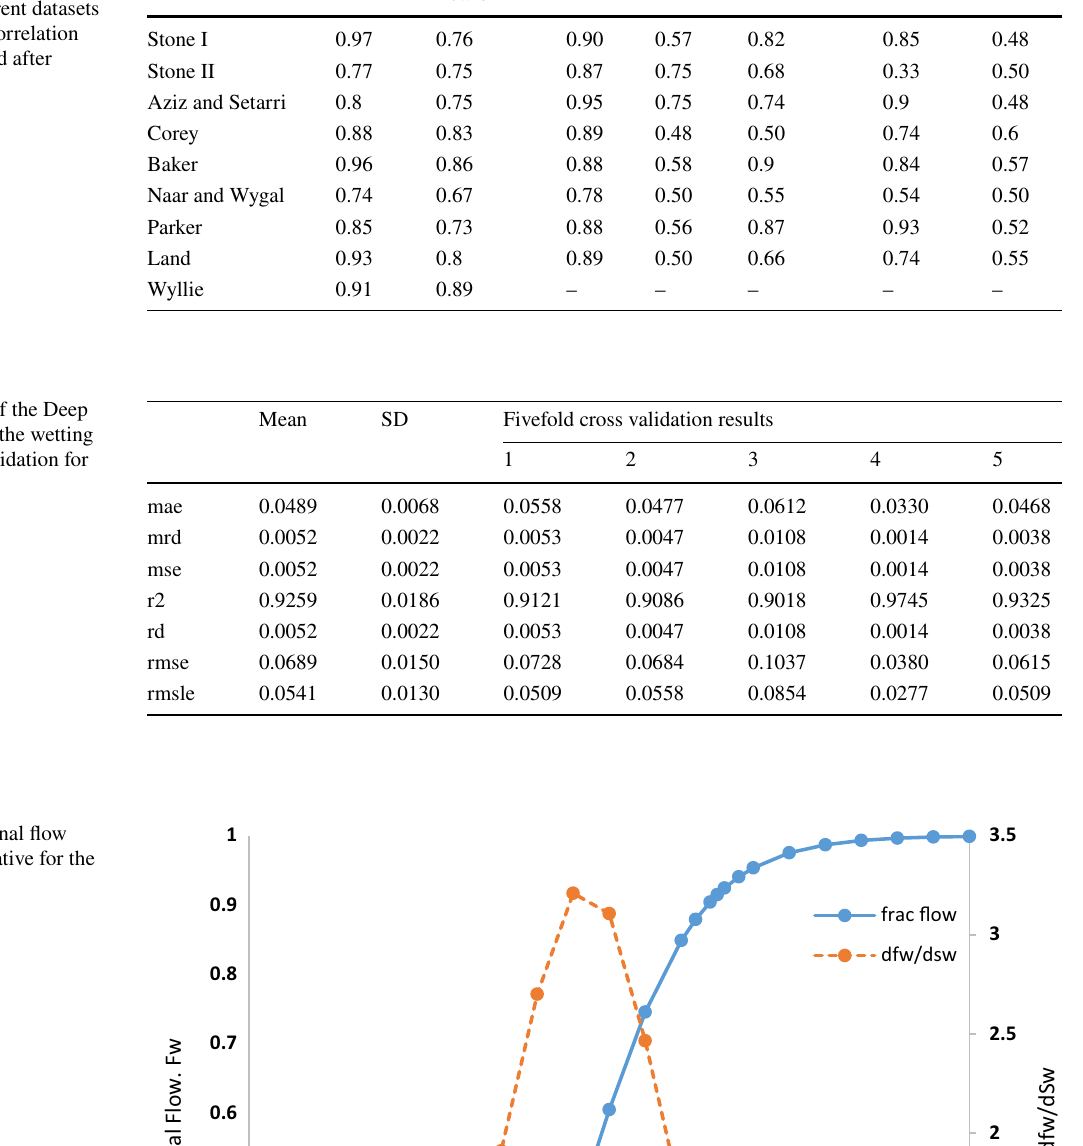
Table 2 Comparison of relative permeability models (vertical) with different datasets (horizontal) using correlation coefficient (Modified after Baker 1988)